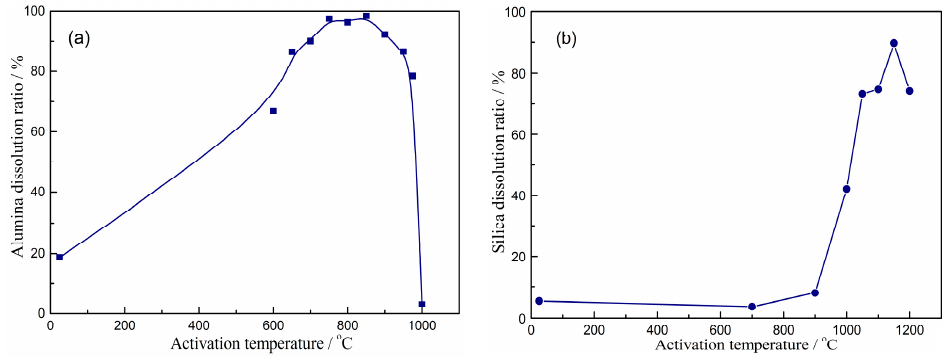
Figure 2. Effects of activation temperature on dissolution of alumina ( a ) and silica ( b ).